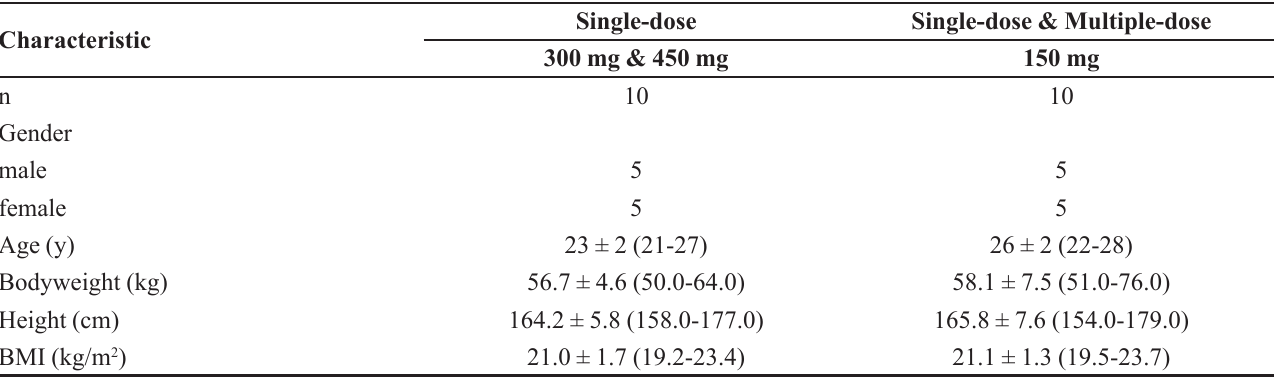
TABLE II - Subject demographics, mean ± SD (range)